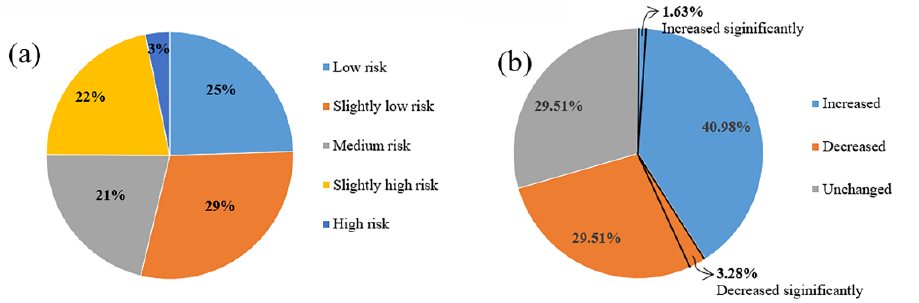
Figure 9. Distribution ( a ) and change ( b ) of combined-events risk of drought and high-temperature heat waves in the North China Plain in summer from 2000 to 2018.